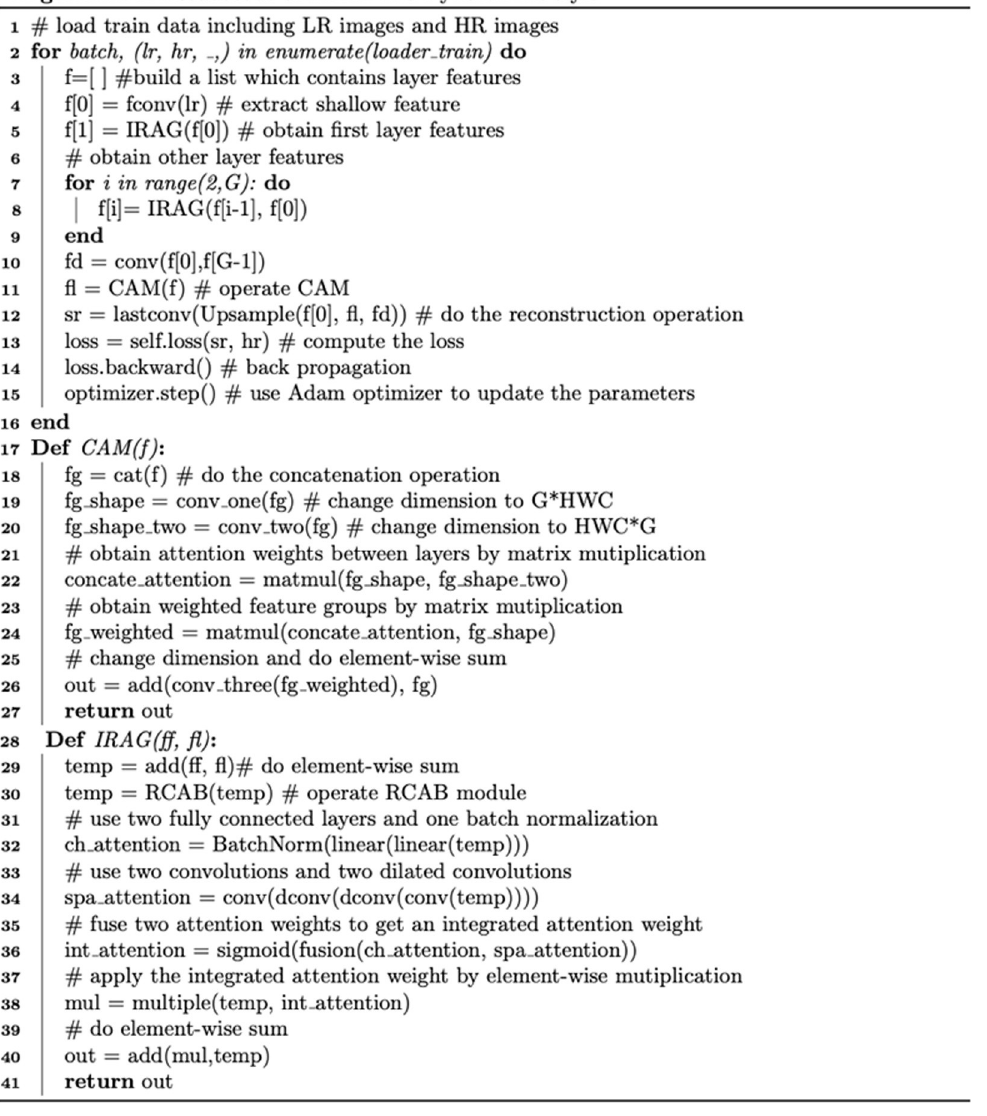
Fig 4. Pseudocode of MPAN in a PyTorch-like style.